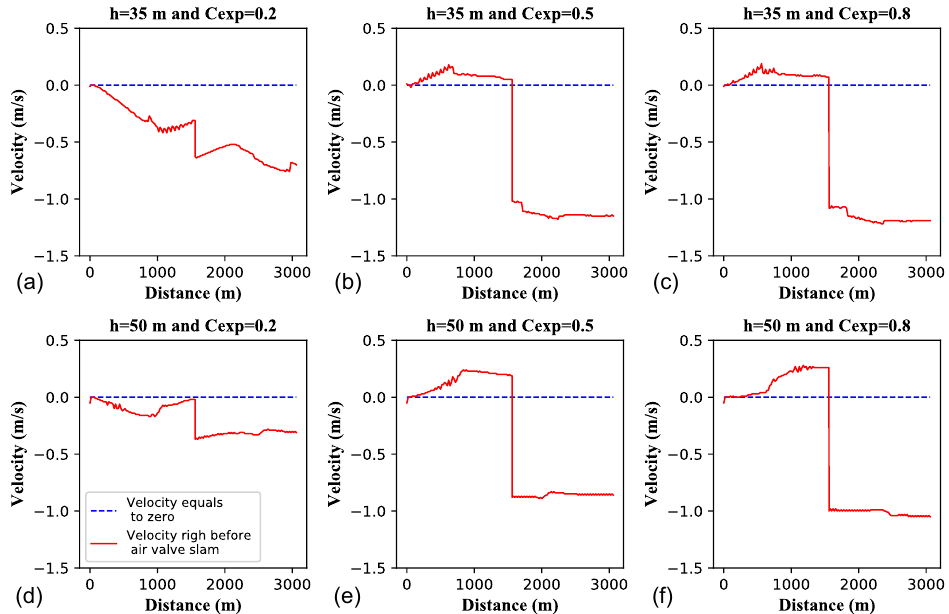
Figure 4. Approaching velocities towards the AVV right before AVV slam in the first transient cycle associated with a pump trip scenario: ( a – c ) for air valve at elevation of 35 m; ( d – f ) for air valve at elevation of 50